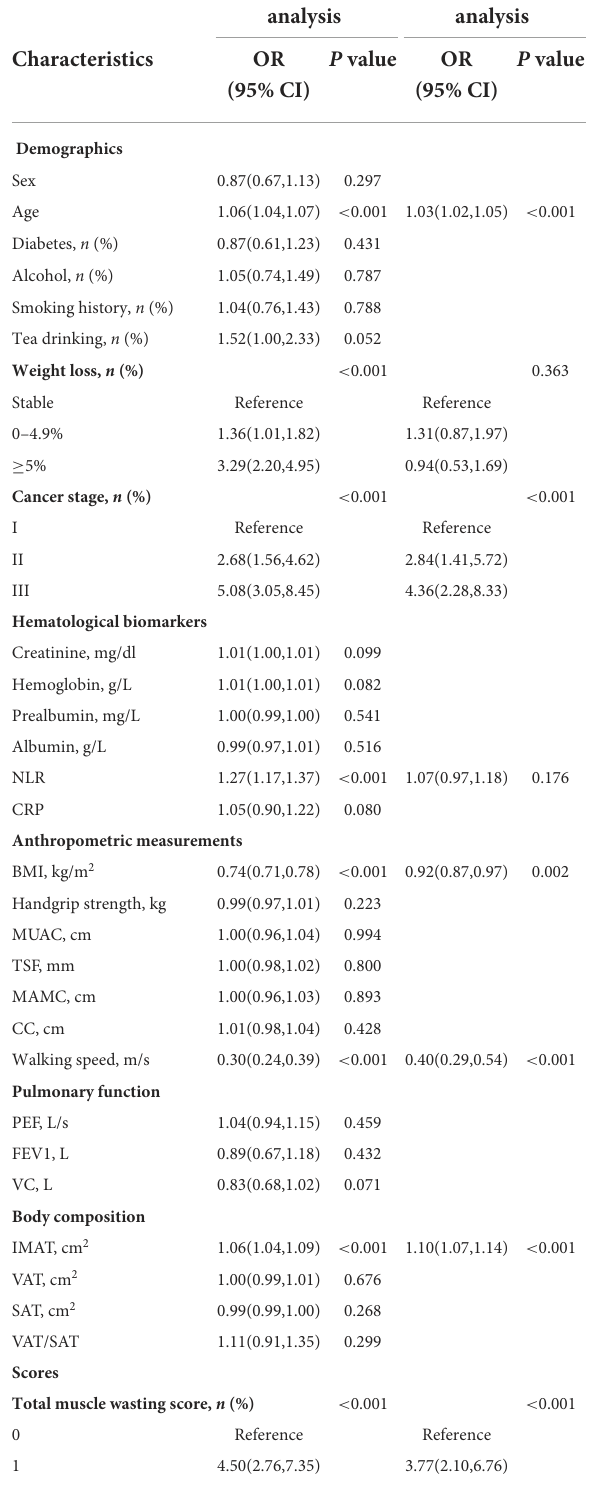
Univariate Multivariate analysis analysis